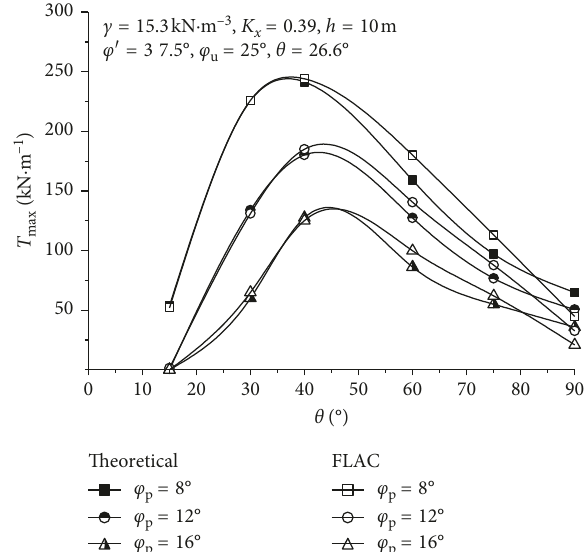
Figure 11: Change of ultimate tensile force in the